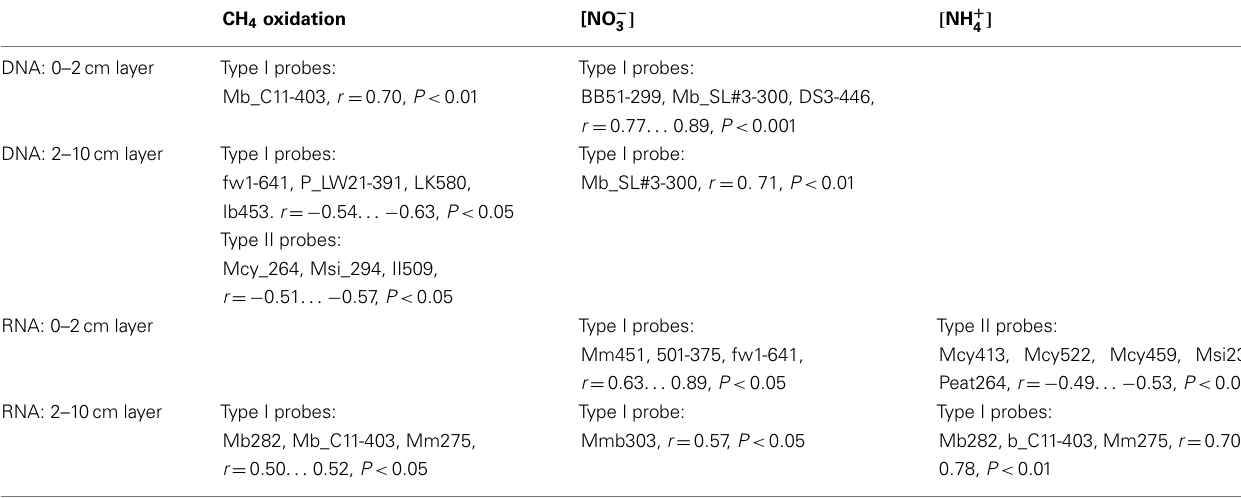
TableA1 | Pearson correlation co-efficients across the experiment between methanotroph relative abundance of pmoA genes/ pmoA transcripts, CH 4 oxidation potential, and concentration of nitrate/ammonium ( n =